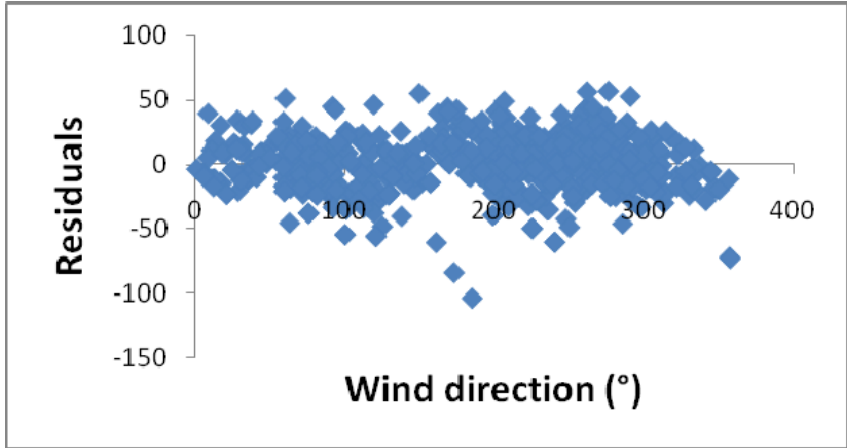
Figure 4. Residual plot for the linear regression on wind direction from masts versus NOGAPS.